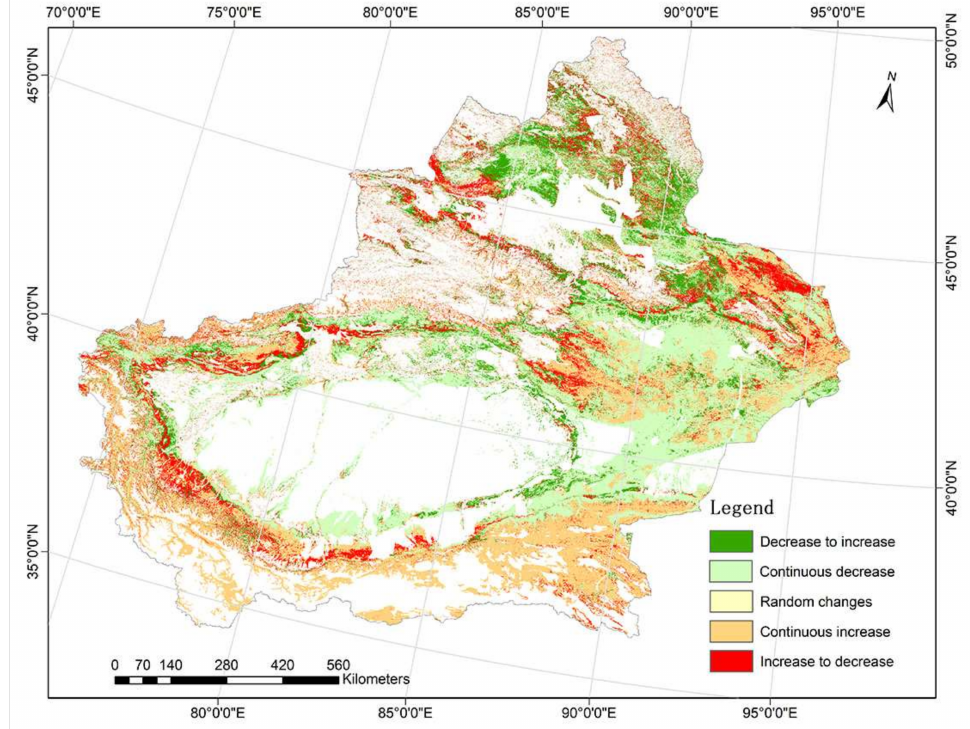
Figure 5. Hurst index for NPP in